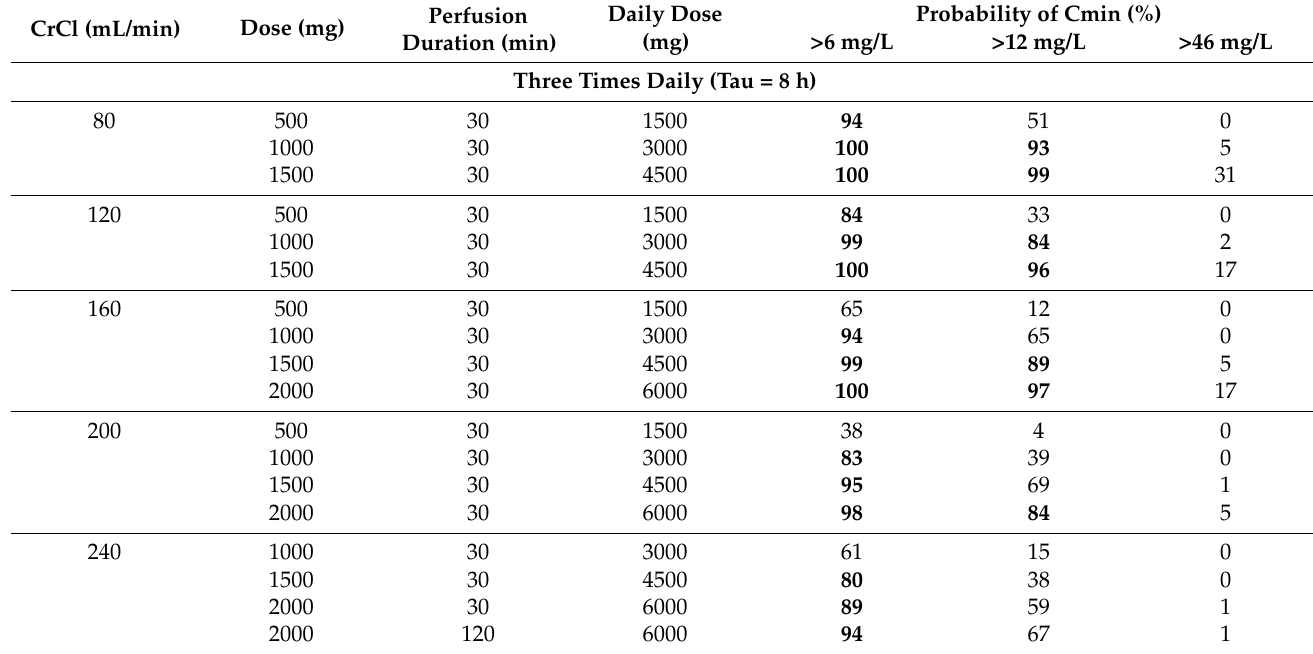
Table 5. Probability of target attainment based on simulations of the final population model with different doses adminis- tered every 8 h. In bold are represented those probabilities ≥